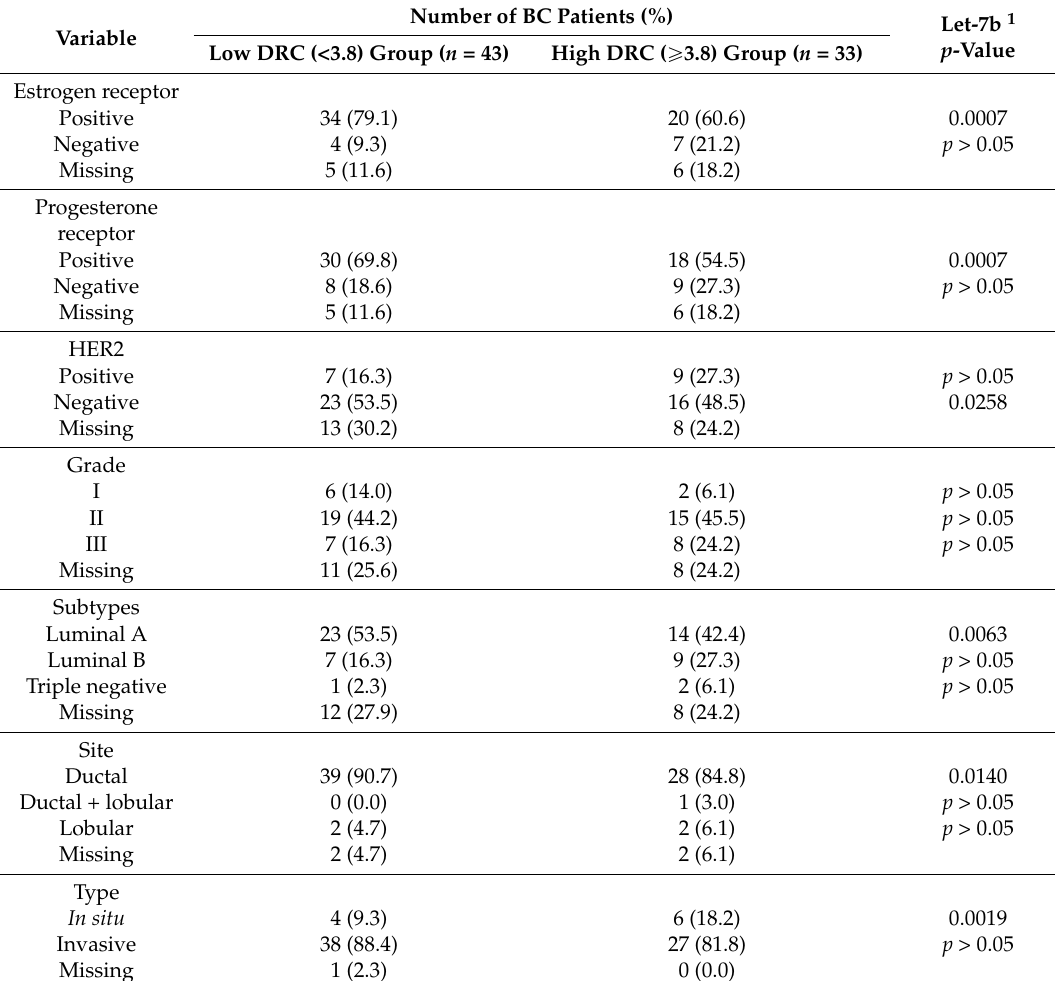
Table 2. Clinicopathological characteristics of breast cancer